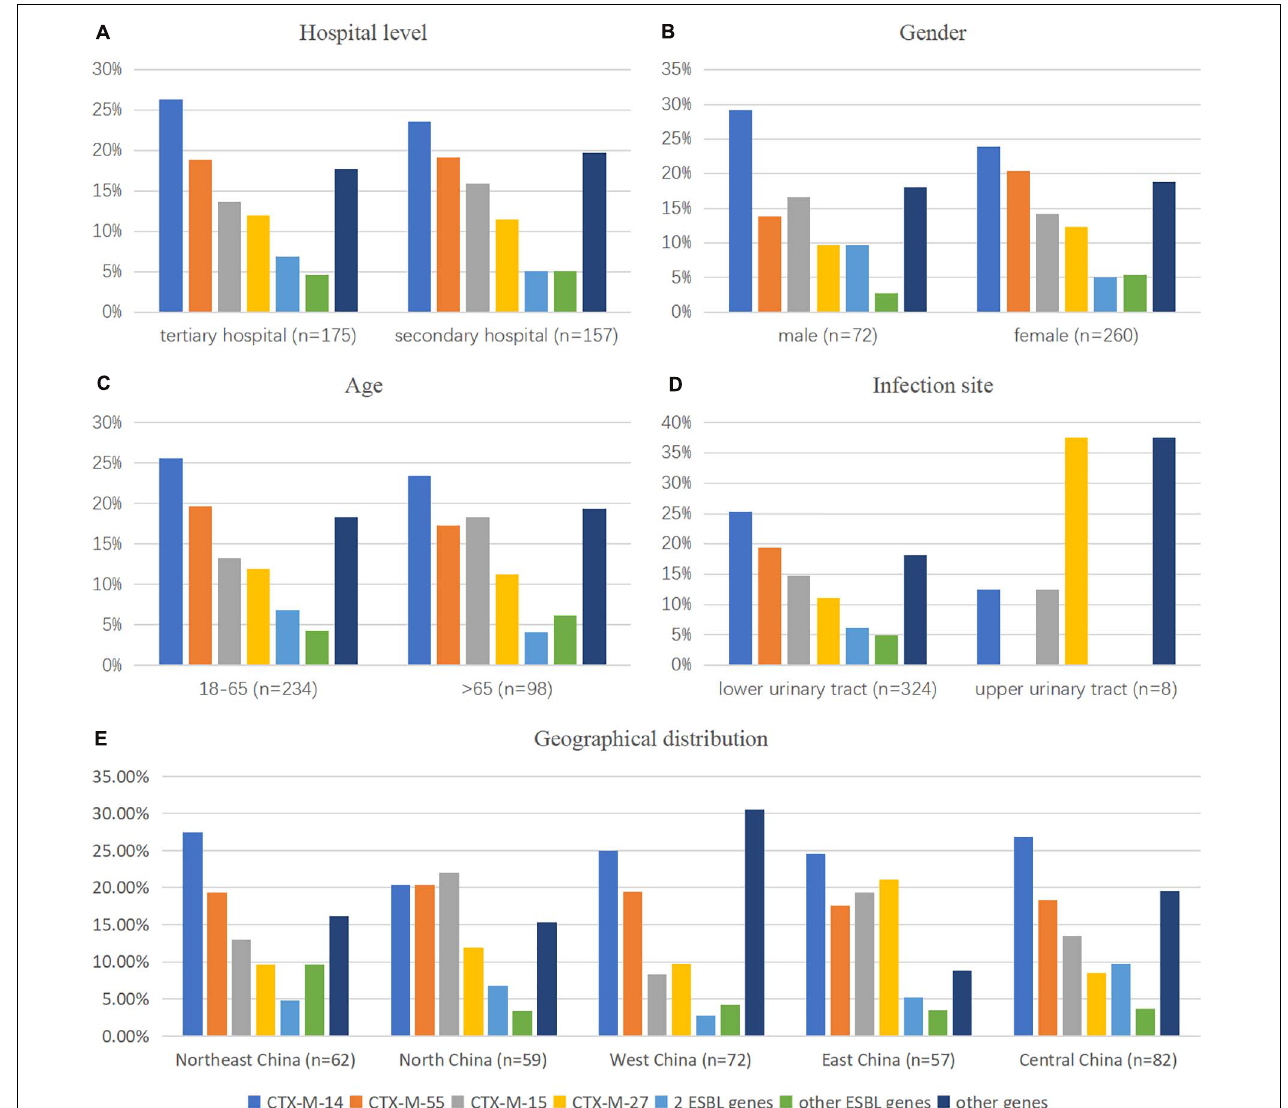
FIGURE 3 | Comparison of the CTX-M gene pattern of E. coli isolates by (A) hospital category, (B,C,E) demographic characteristics, and (D) clinical features. 2 ESBL genes : CTX-M-1 coexisted with CTX-M-9 groups; other ESBL genes : genes that existed in less than 10 isolates in this study, such as CTX-M-3 ( n = 5), CTX-M-64 ( n = 3), CTX-M-65 ( n = 9), and CTX-M-79 ( n = 1); other genes : isolates with genes except ESBL genes detected in this